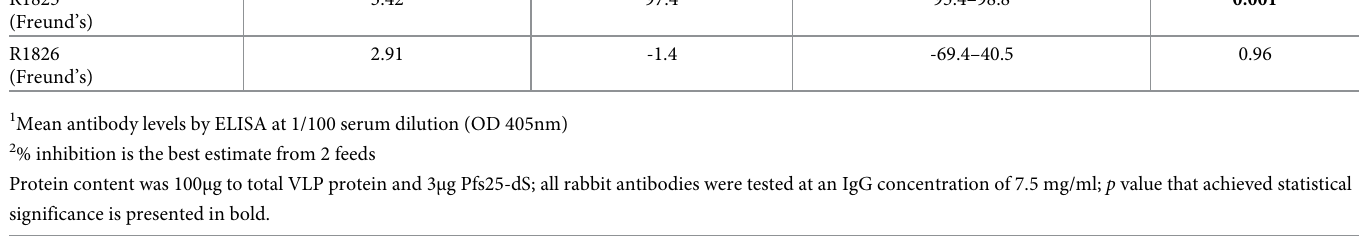
Table 3. Assessment of transmission-blocking activity of rabbit antibodies against Pfs25-dS/dS VLPs by SMFA. Rabbit ID